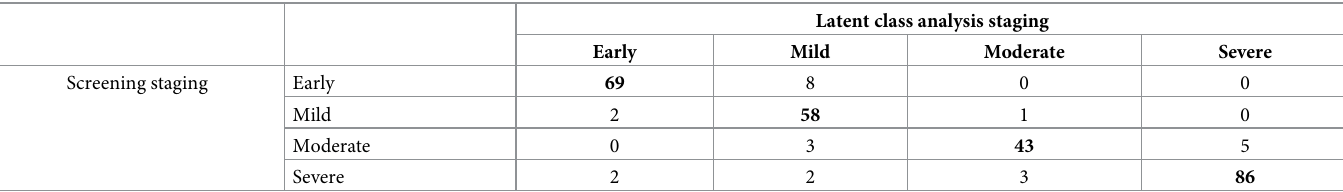
Table 5. Comparison of number of participants under each